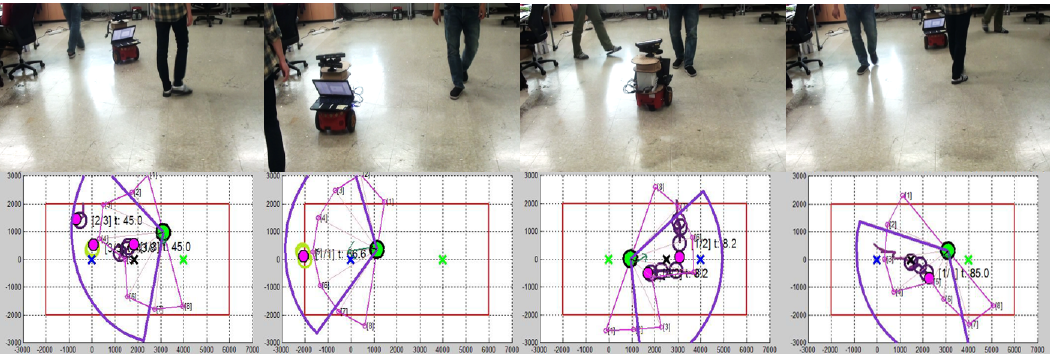
Figure 7. Motion prediction experiments using the proposed motion model, FactGP M [24] (reproduced with permission from Eunwoo Kim, Sungjoon Choi, Songhwai Oh, Structured Low-Rank Matrix Approximation in Gaussian Process Regression for Autonomous Robot Navigation; published by IEEE, 2015). A pink circle is the prediction made by FactGP M given past pedestrian positions (purple or yellow-green circles). The violet fan-shaped region is the field of view of two Kinect sensors and the pink fan-shaped region shows sensing responses from sonar sensors of the Pioneer robot. Each column consists of a photo taken by a camera and the internal state of the robot. Best viewed in